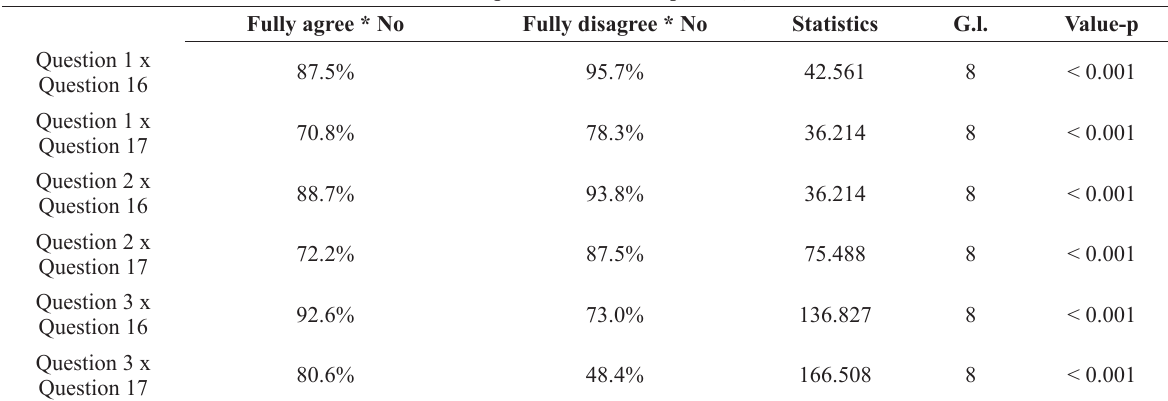
Pearson’s Chi-squared Test – Compared Questions.